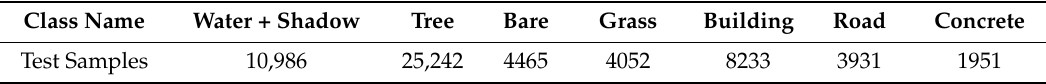
Table 3. Details of the samples for the Fancun image.